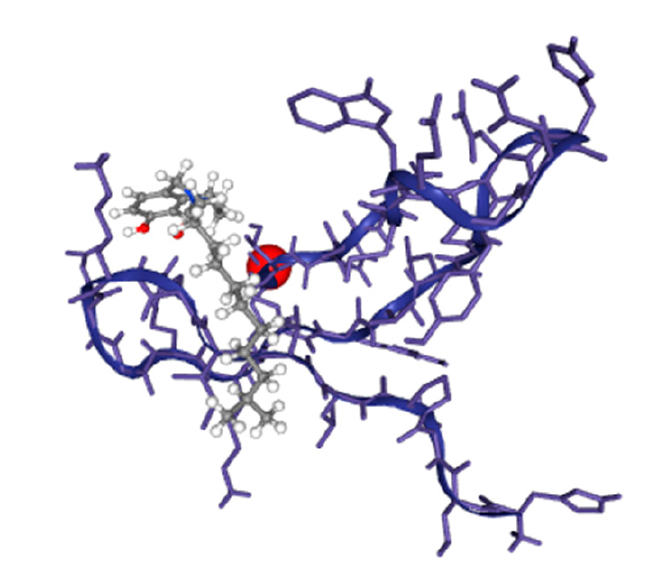
Figure 9. The docked complex of AIGT and BCR-ABL1 where the grey color ligand is the AIGT.